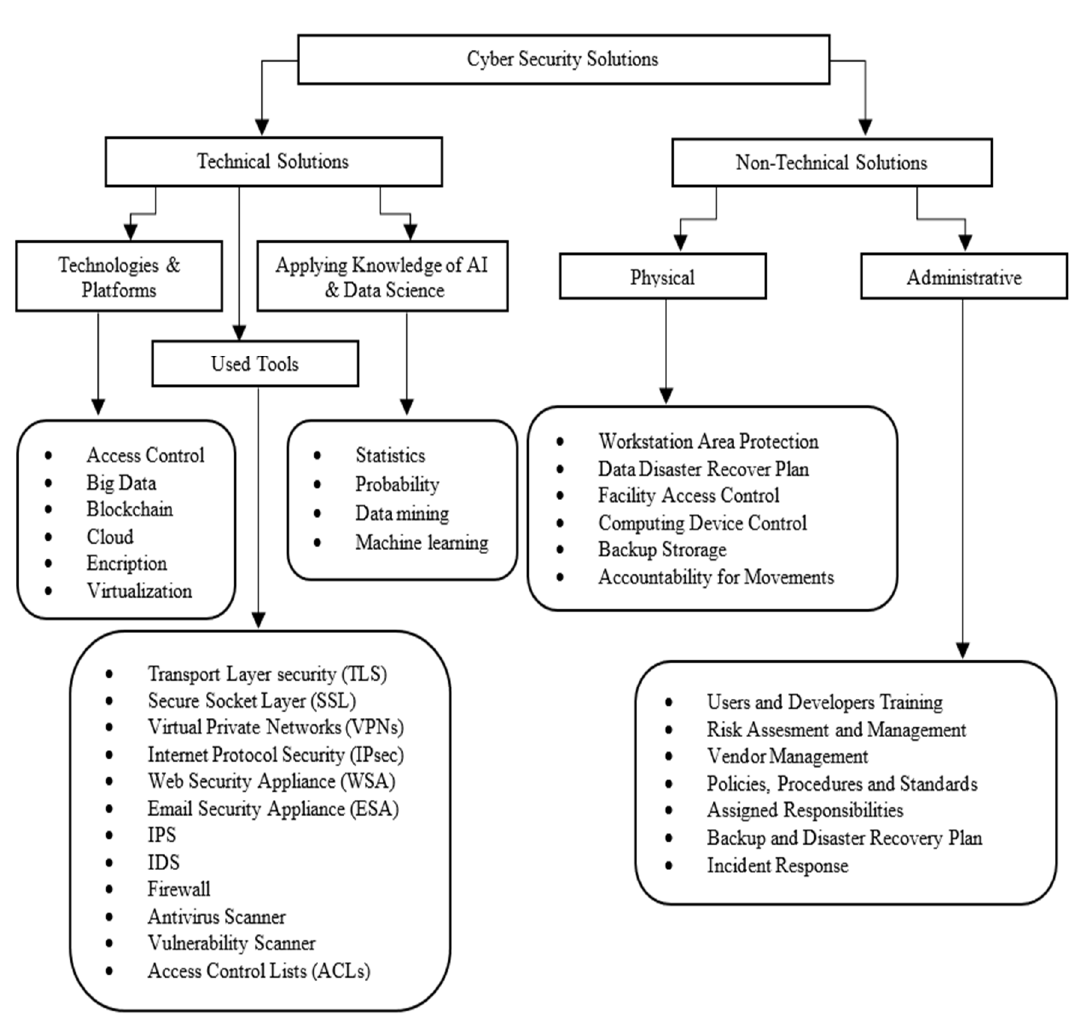
Figure 9.Represent the technical and non-technical cyber security solutions . Figure 9. Represent the technical and non-technical cyber security